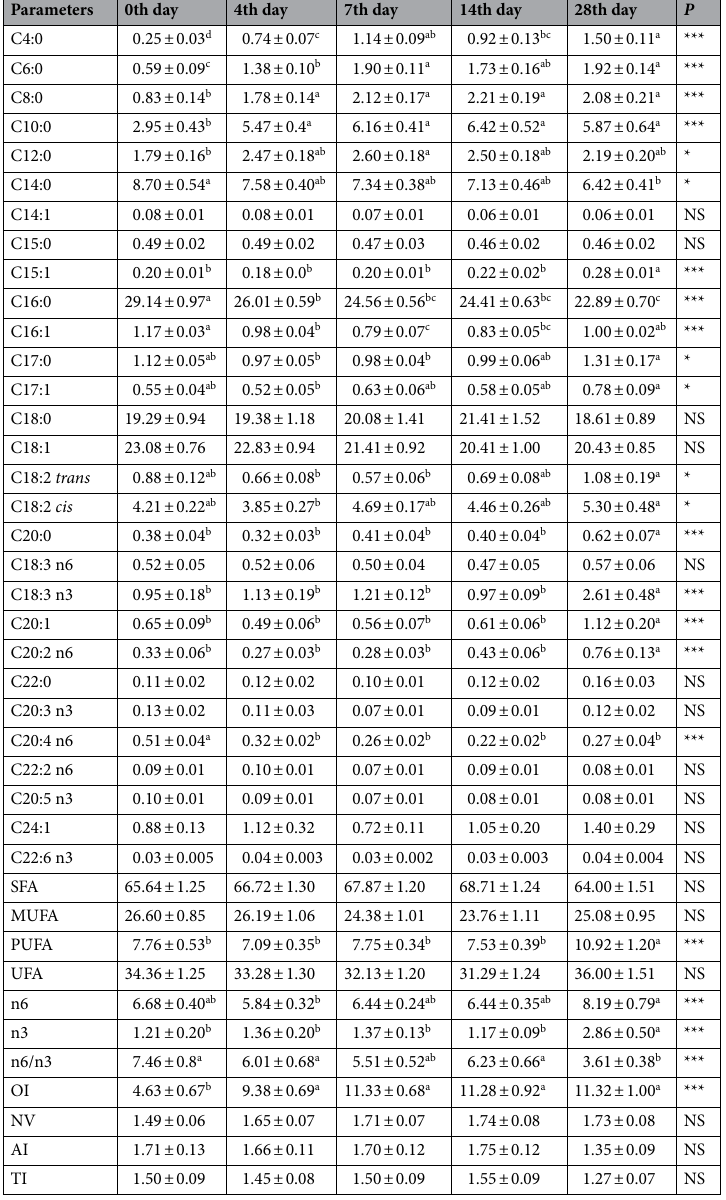
Table 1. Fatty acids profile of milk samples in different stages of lactation; *: P < 0.05; **: P < 0.01; ***: P < 0.001; NS: Not significant; a, b, c, d: Means with different letters in rows differ significantly; OI